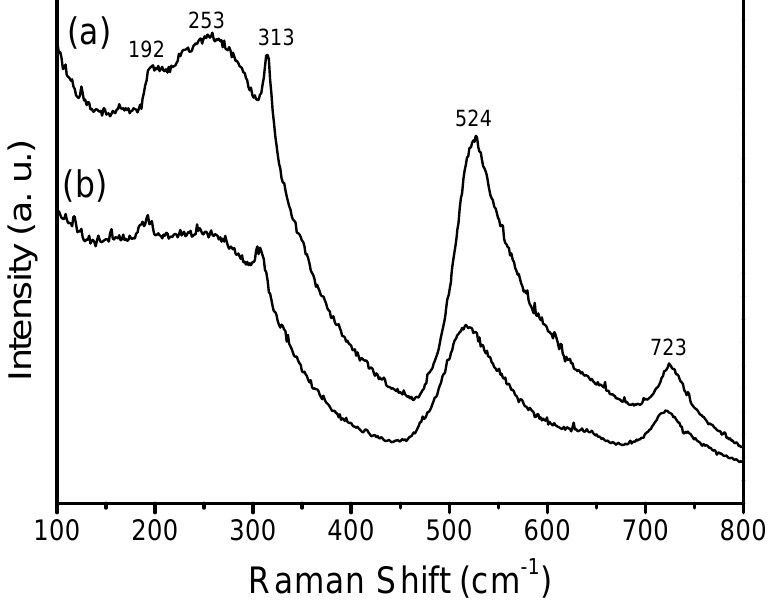
:Eu 3+ powder (a) and film 3